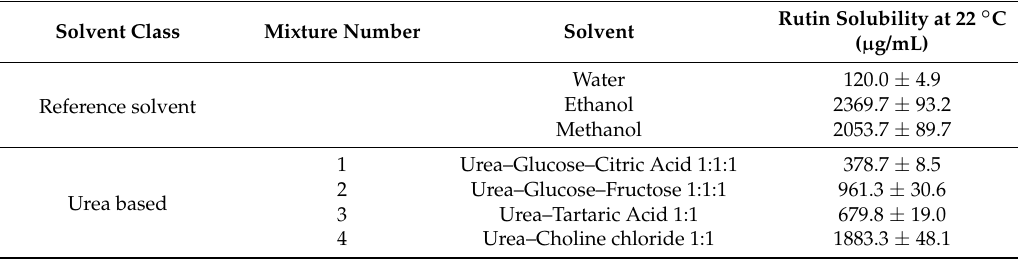
Table 1. Solubility of rutin (mean ± SD of 3 determinations) in each solvent. The solubility in all solvents were significantly different from solubility in water ( p -values <